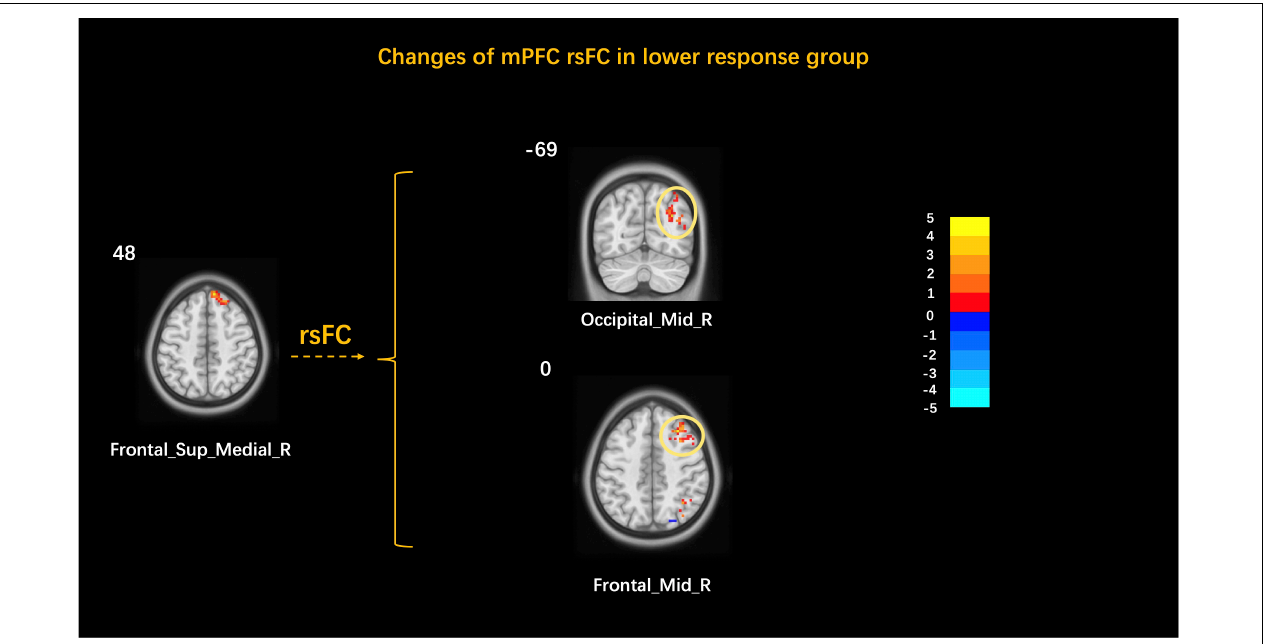
FIGURE 4 | Changes of the mPFC rsFC in the higher response group. Occipital_Mid, middle occipital gyrus; Frontal_Mid_Orb, orbital middle frontal gyrus; L, left; R, right.